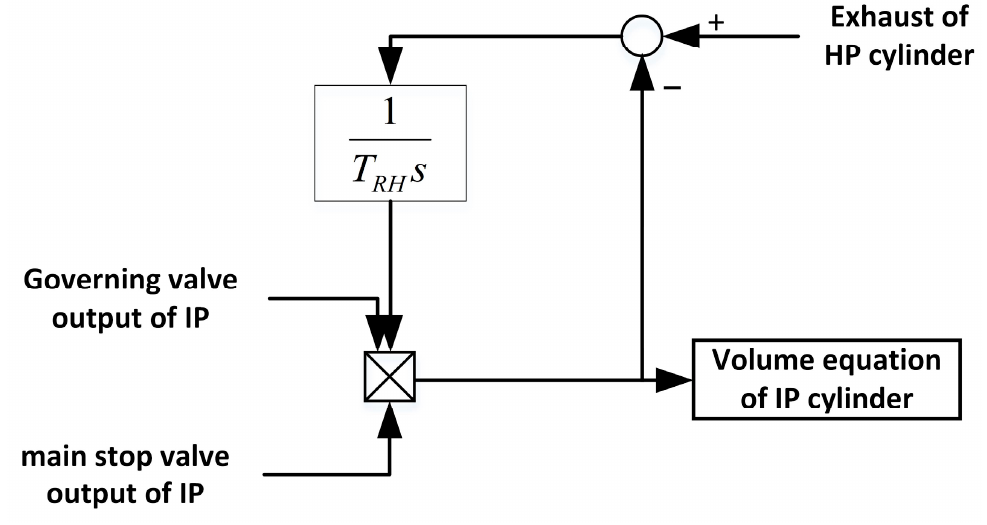
Figure 5. Reheat system model.